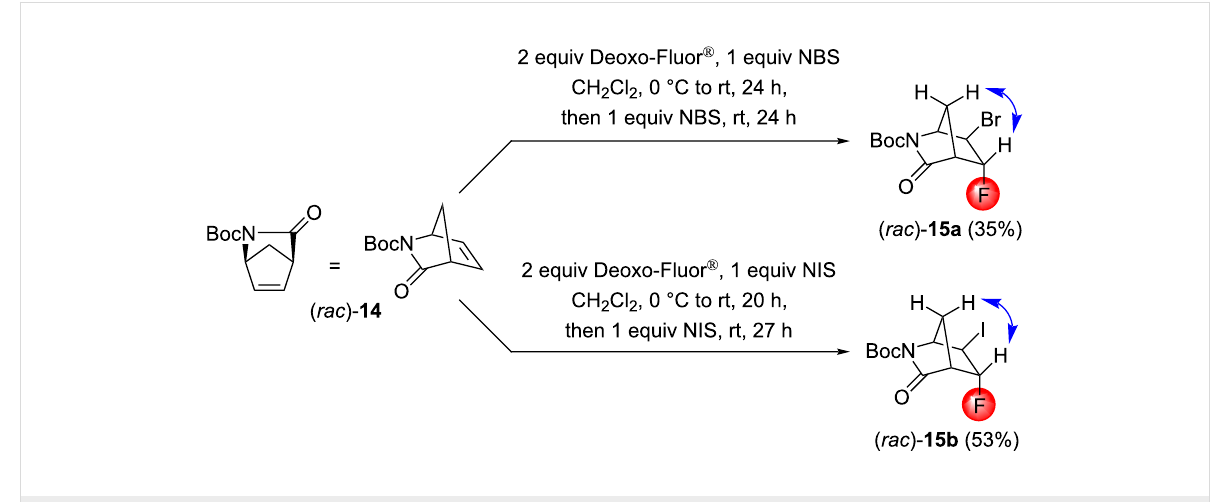
Scheme 8: Halofluorination reactions of the γ -lactam ( rac ) - 14 . Relevant NOESY interactions are indicated by two-headed arrows.